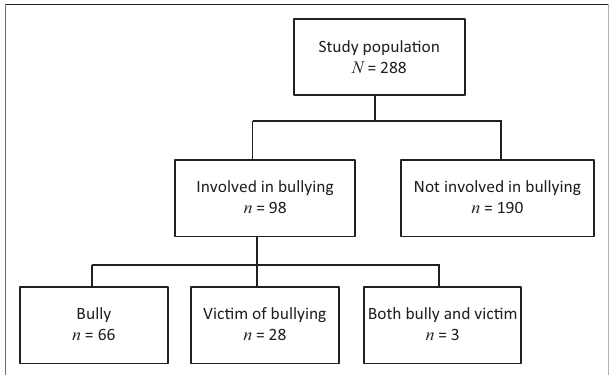
FIGURE 1: Involvement of children in bullying.